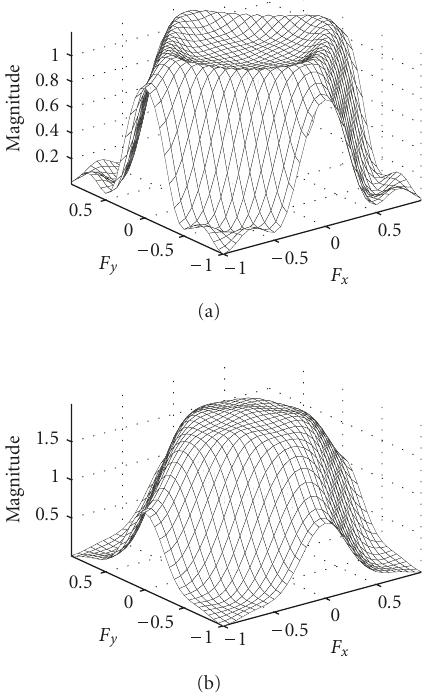
Figure 7: Frequency responses of the (a) lowpass analysis and (b) lowpass synthesis filters of OPT1.